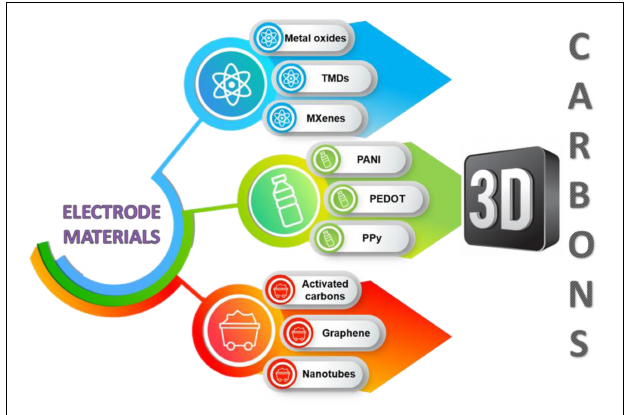
FIGURE 4 | Division of EDLC electrode